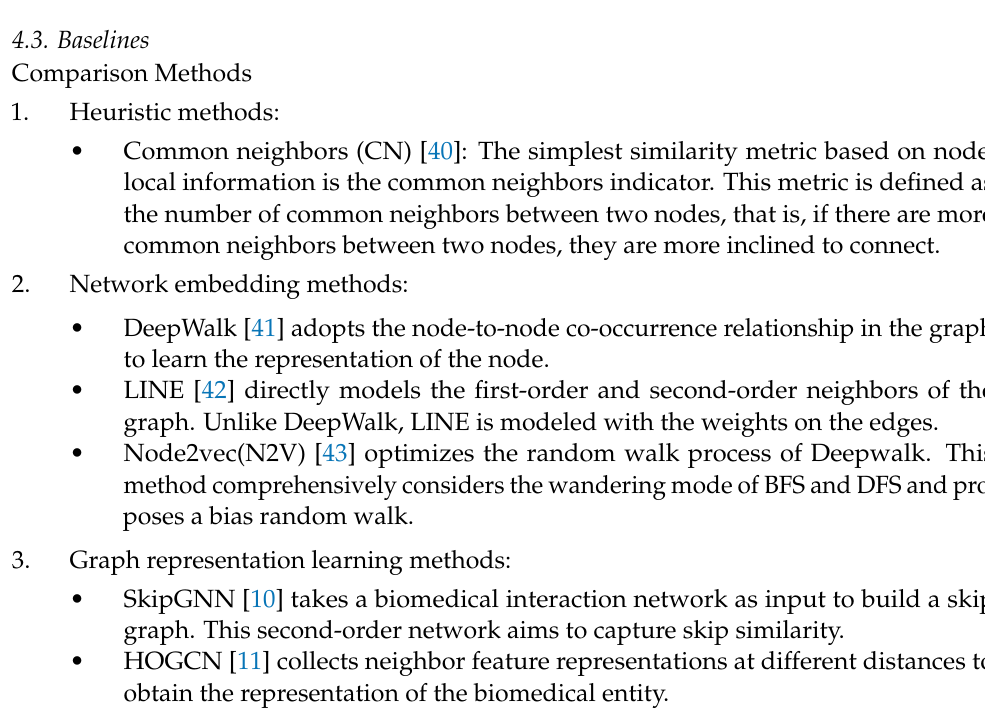
Figure 2. Dataset visualization for the four datasets. The size and color shade of a node are positively correlated with the degree of the node. The network topologies of the four datasets vary greatly, and the DDI dataset is the